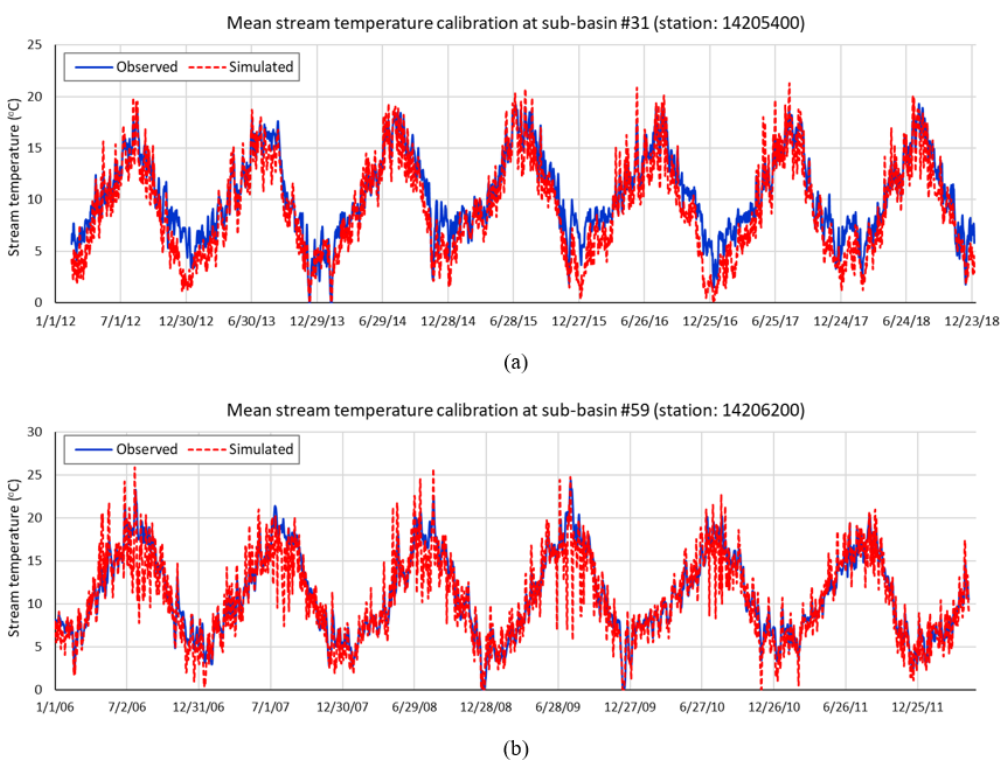
Figure 3. (a) Mean stream temperature calibration at USGS-14205400 station (outlet of sub-basin #31) and (b) station 14206200 (outlet of sub-basin